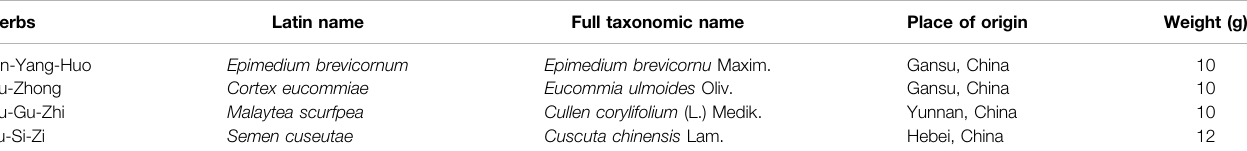
TABLE 1 | Detailed information of Yin-Yang-Huo, Du-Zhong, Bu-Gu-Zhi and Tu-Si-Zi. Herbs